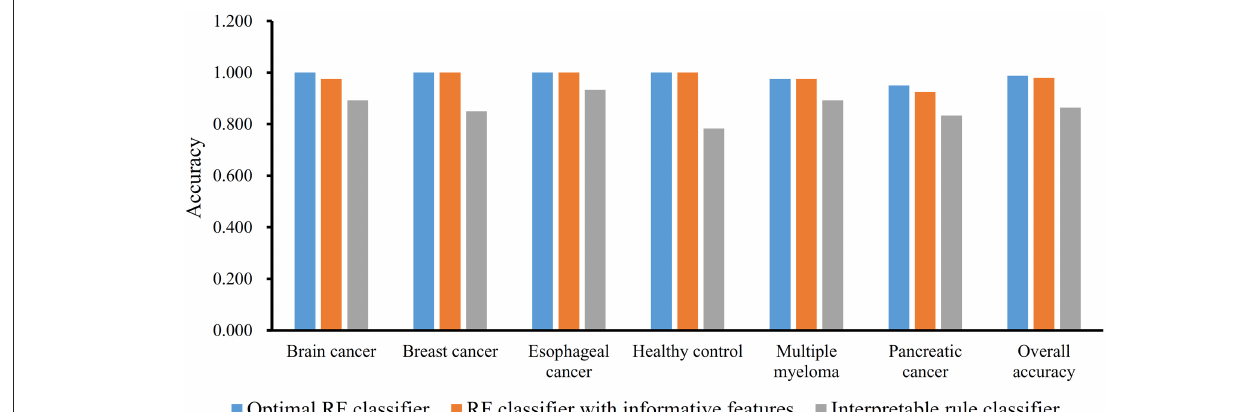
FIGURE 3 | Performance of three classifiers on six groups in dataset-1 and overall accuracy.